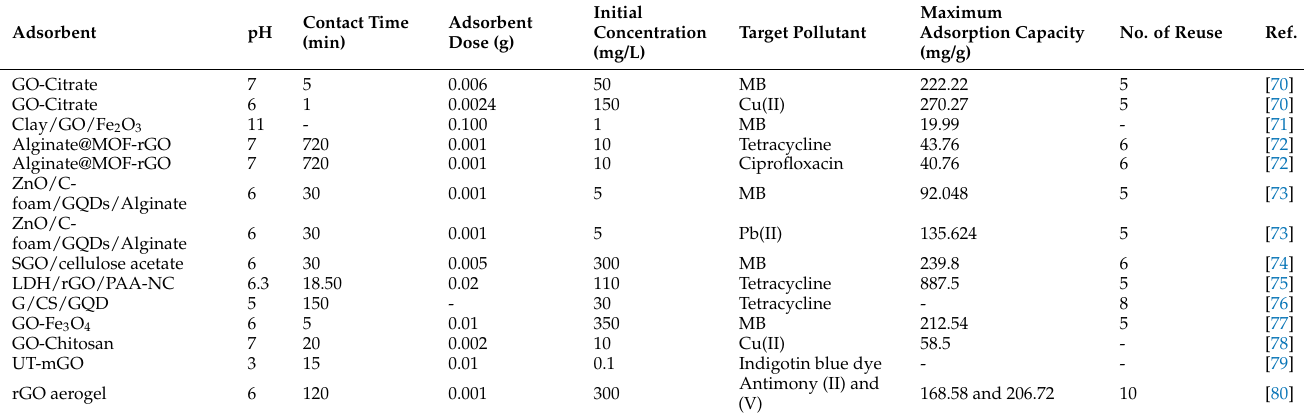
Table 3. Application of GO-based nanomaterials for the removal of wastewater